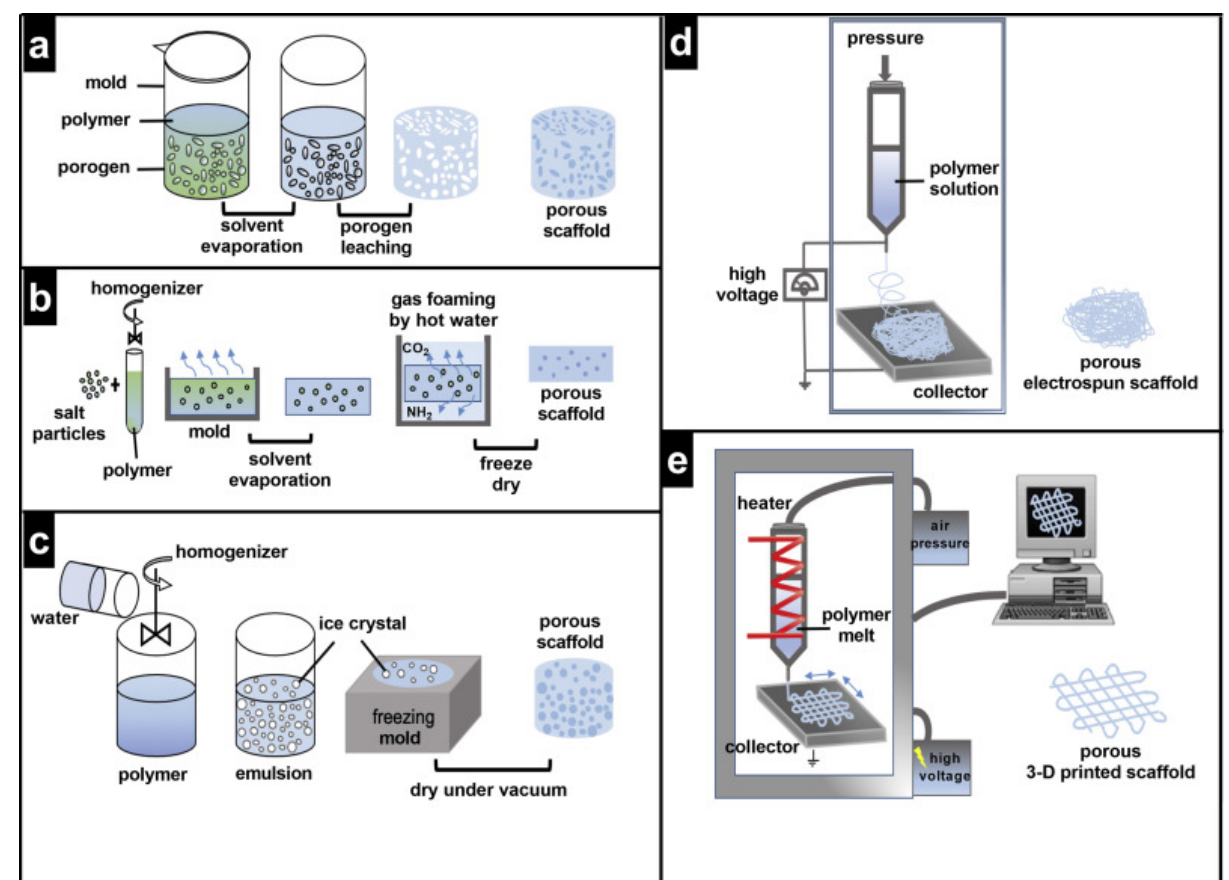
Figure 1. Methods for pore fabrication ( a ) Porogen leaching, ( b ) Gas foaming, ( c ) Freeze-drying, ( d ) Solution electrospinning, ( e ) Melt electrowriting and 3D printing, reproduced from [29] Creative Commons CC-BY license.